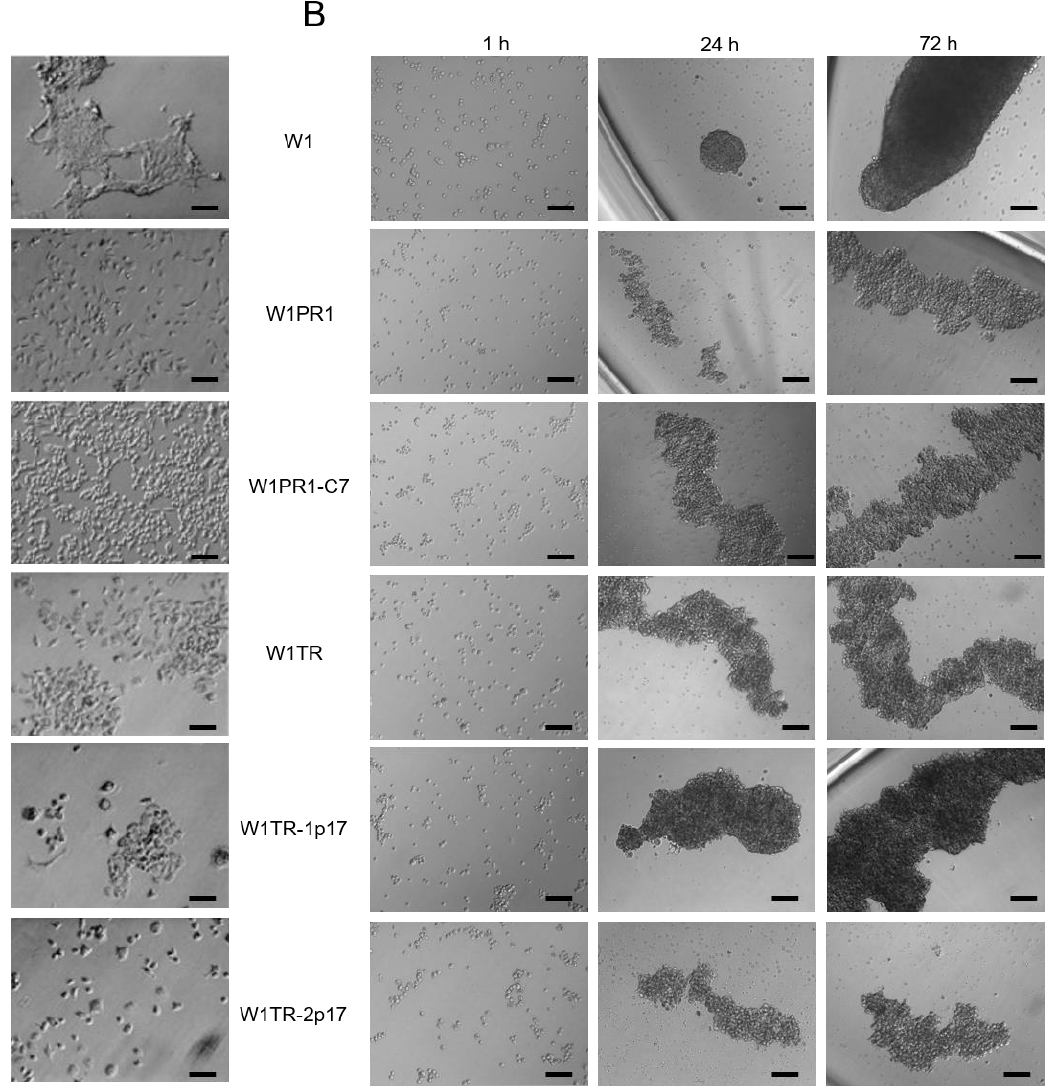
Figure 6. ( A ) Morphology of W1, W1PR1, W1PR1-C7, W1TR, W1TR-1p17 and W1TR-2p17 cell lines growing under 2D cell culture conditions. ( B ) Process of spheroid formation of W1, W1PR1, W1PR1-C7, W1TR, W1TR-1p17 and W1TR-2p17 cell lines. 10,000 cells of each cell line were seeded in 96-well plate. Images were acquired using an inverted microscope (Olympus). Objective 10×. Time in hours (h). Scale bar = 100 µm.